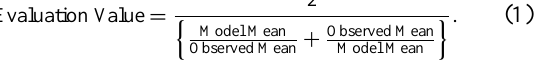
Figure 1. Mean of all models for the annual mean change in LAI (m 2 m − 2 ) over time relative to current (1981–2000) for 2011– 2030 (a) , 2041–2060 (b) and 2081–2100 (c) for